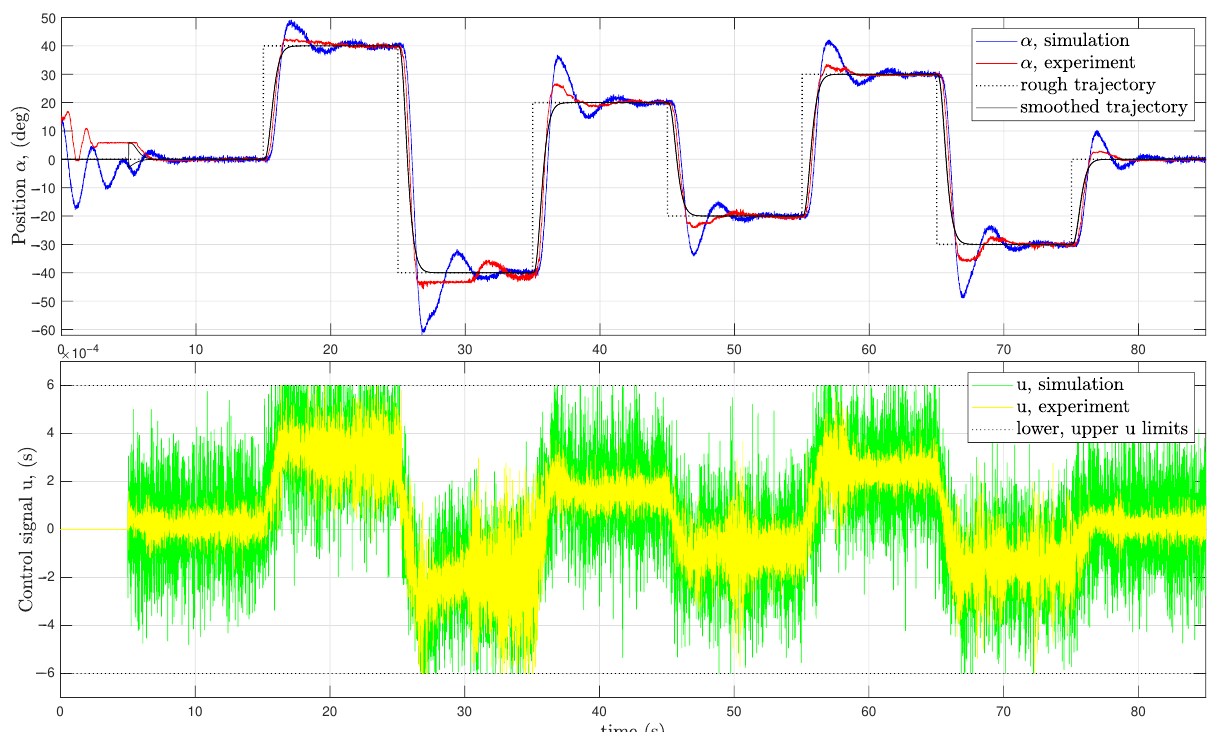
Figure 15. Experimental and simulation results for trajectory tracking with a “PID with nonlinear feedforward” con- trol